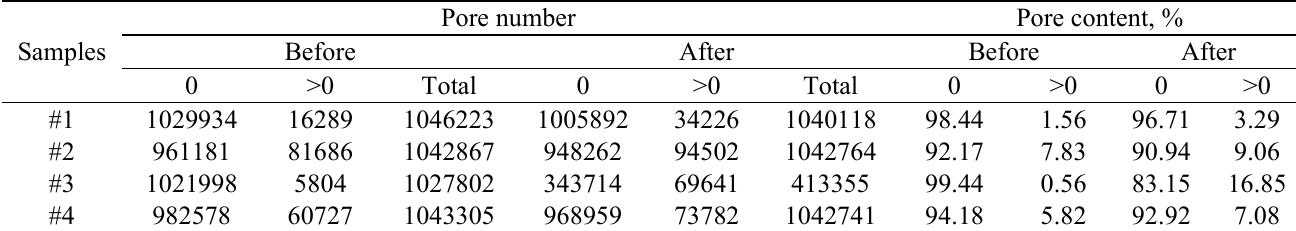
Table 3—Numbers and contents of pores with different coordination numbers.